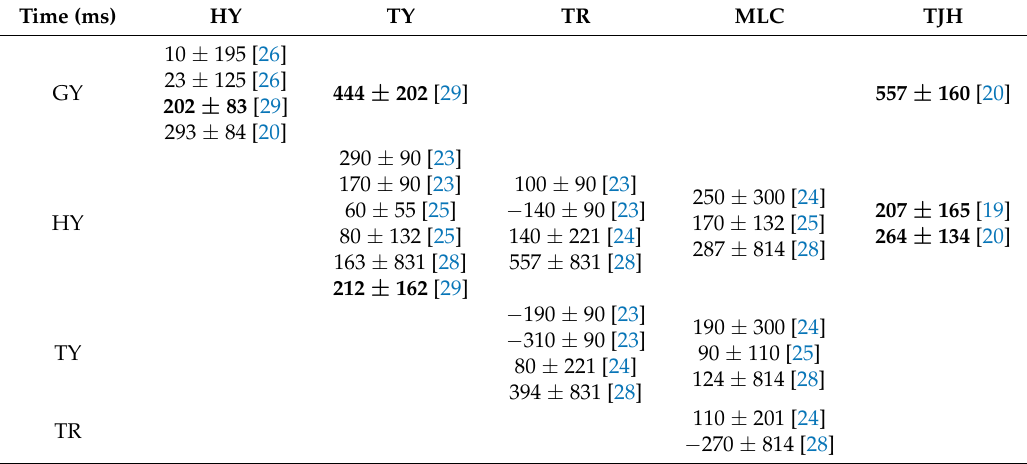
Table 4. Time anticipation (column 3, mean ± standard deviation) between gaze (GY), body segments (TY, TR), trajectory heading (TJH) and body center of mass medio-lateral displacement (MLC).